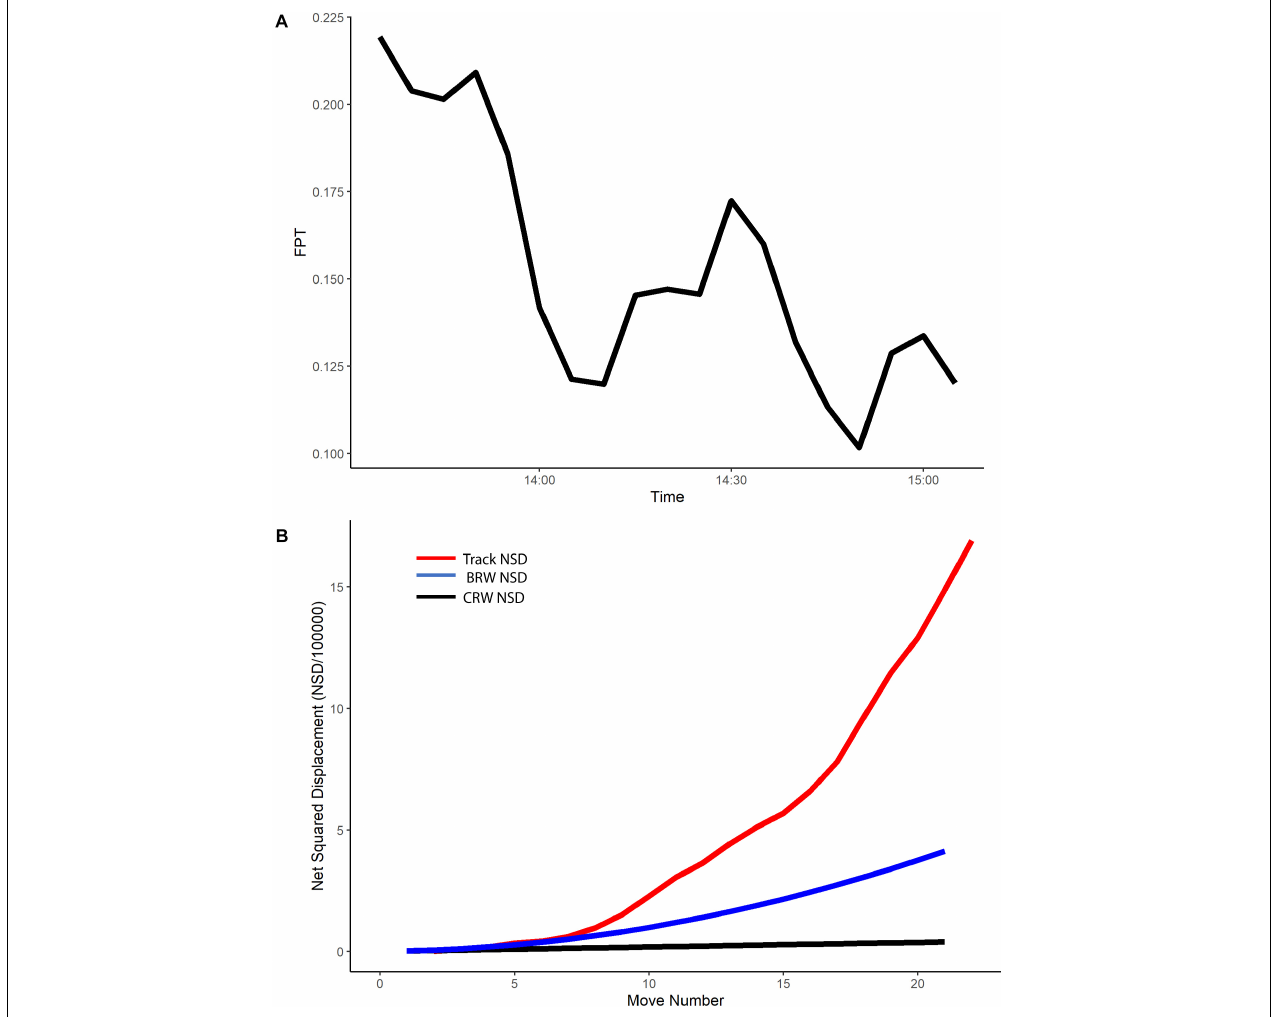
FIGURE 2 | For example neonate track (ID no. E5): (A) First passage time (FPT, hours) versus time, and (B) Net squared displacement (NSD, m 2 ) versus move number for example neonate track. The red line represents the NSD for the true neonate track, the blue line the expected NSD for a biased random walk (BRW), and the black line the expected NSD for a correlated random walk